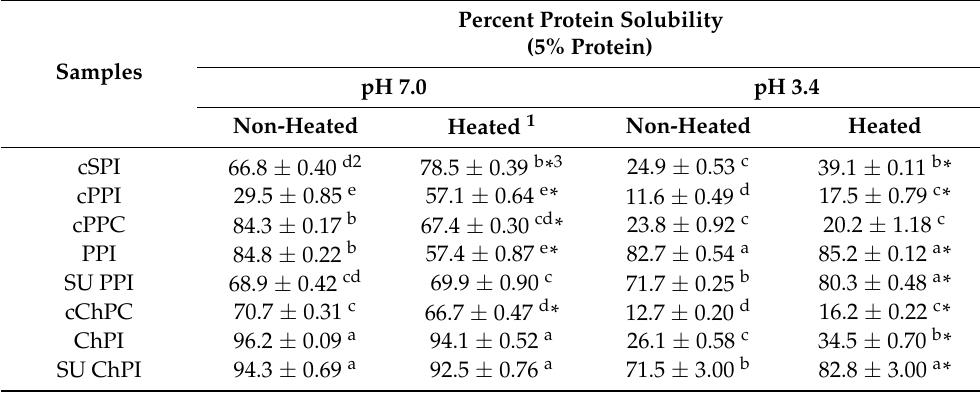
Table 3. Protein solubility of benchtop and scaled-up pea and chickpea protein isolates (PPI, SU PPI, ChPI, and SU ChPI), as well as commercial SPI, PPI, PPC, and ChPC.